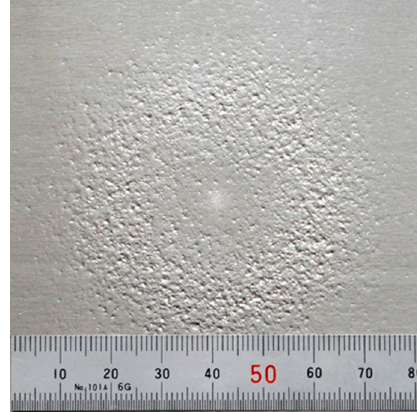
Figure 8. Typical treatment area by a fixed cavitating jet (pure aluminum, nozzle diameter d = 2 mm, upstream pressure p 1 = 30 MPa, downstream pressure p 2 = 0.1 MPa, standoff distance s = 262 mm, exposure time t = 1 min) [4].